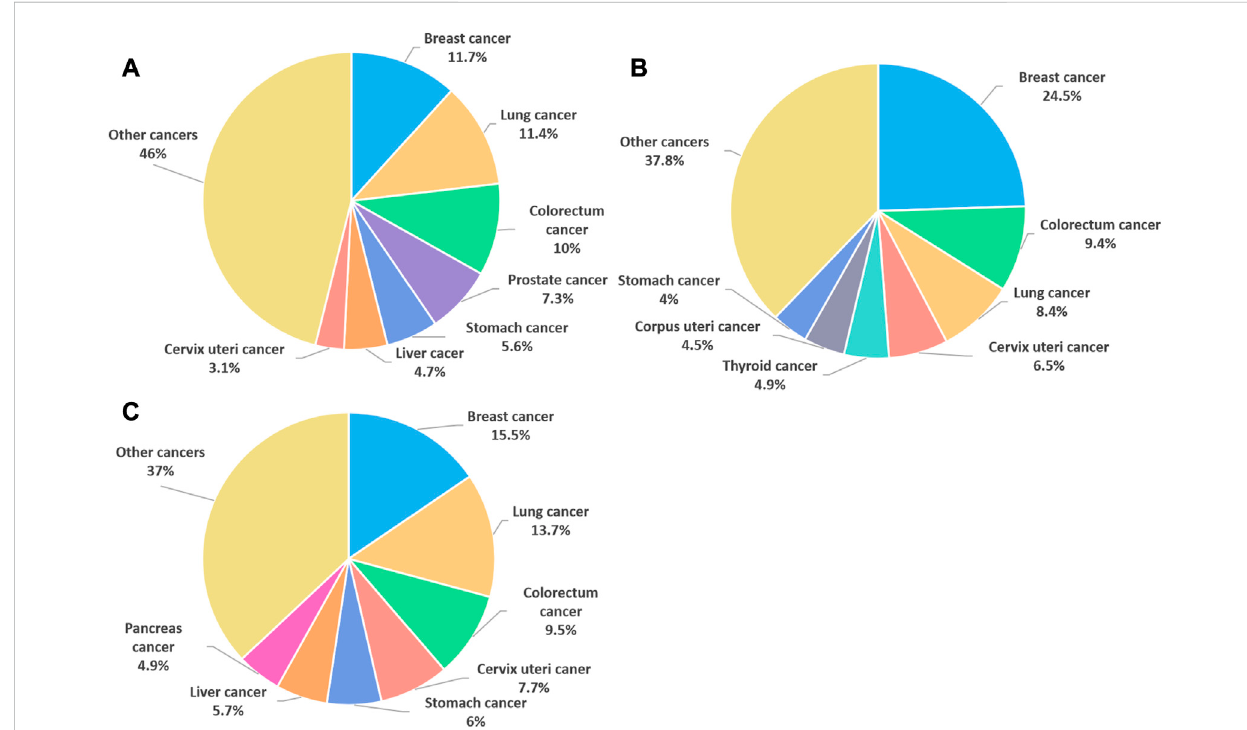
FIGURE 1 The cancer cases and deaths in 2020. (A) Percentage of new cancer cases worldwide in 2020, both sexes. (B) Percentage of new cancer cases worldwide in 2020, females. (C) Percentage of female cancer deaths worldwide in 2020. (data source: The World Health Organization).